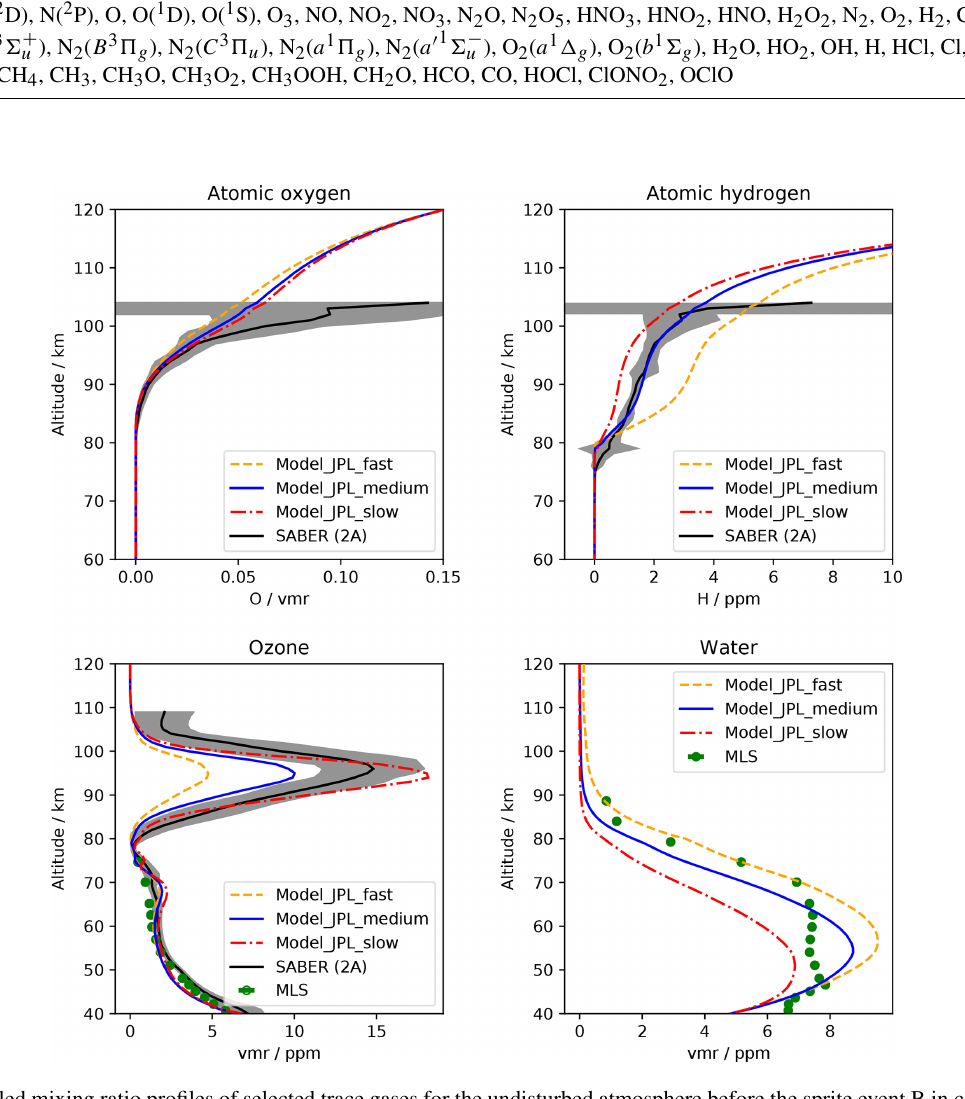
Figure 1. Modelled mixing ratio profiles of selected trace gases for the undisturbed atmosphere before the sprite event B in comparison with satellite data. The model results are for 18 November 2009, 00:15LT, solar zenith angle 165.7 ◦ at 6.7 ◦ N, 79 ◦ W. For all model runs, JPL rate coefficients were used. Shown are results for slow, medium, and fast vertical transport. Black solid lines show SABER Level 2A (v2) data zonally averaged night-time values for 18 November 2009 and latitudes 0–13.5 ◦ N; the mean solar zenith angle is 160 ◦ . The grey areas depict ± 1 standard deviation of these profiles. Green data points depict MLS (Level 2, v04) zonally averaged night-time values for 18 November 2009 and latitudes 33 ◦ S–40 ◦ N; the mean solar zenith angle is 142 ◦